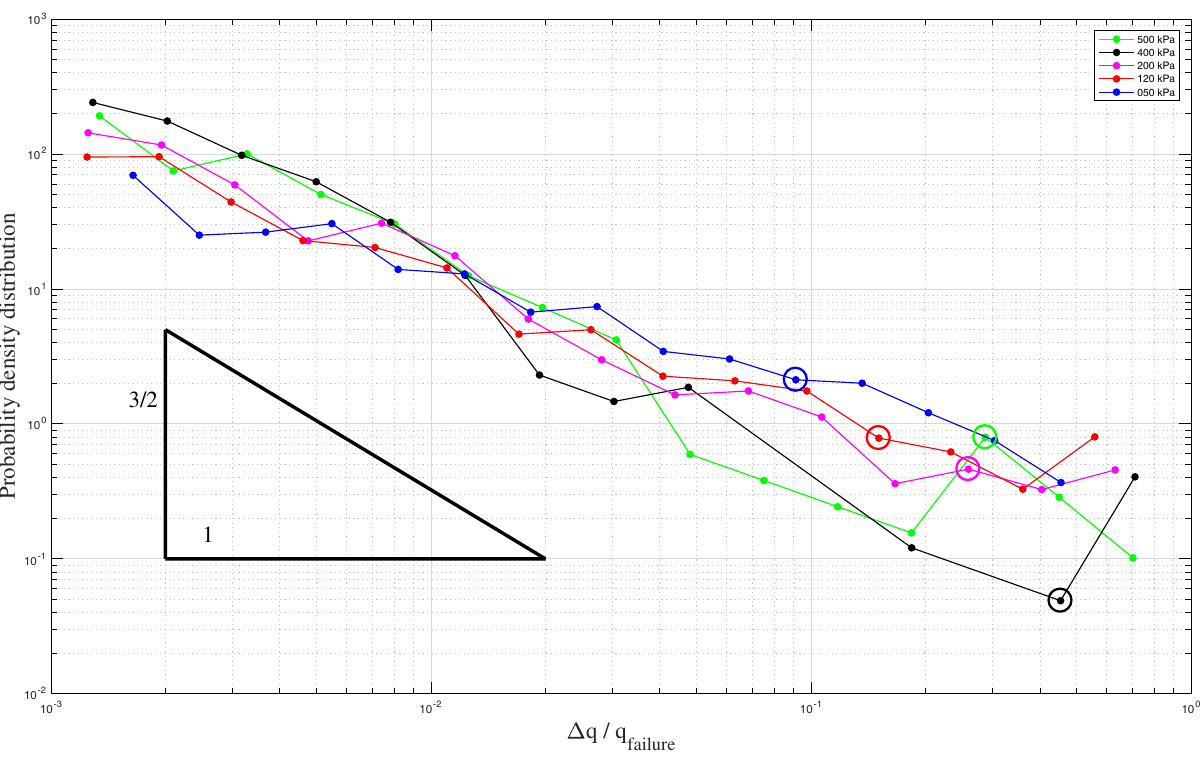
Figure 3. Probability density distributions of deviatoric stress drop (cid:31) q normalized by q f for various constant confining stresses p 0 , from 50 up to 500 kPa, following the simple power-law of 3/2 (triangle). The largest saturated laboratory stick-slip motions have � q / q f (cid:31) 0.7, approaching the limit value of 1. Large hollow circles signal the particular case of the first stick-slip events with large deformations. The results are binned